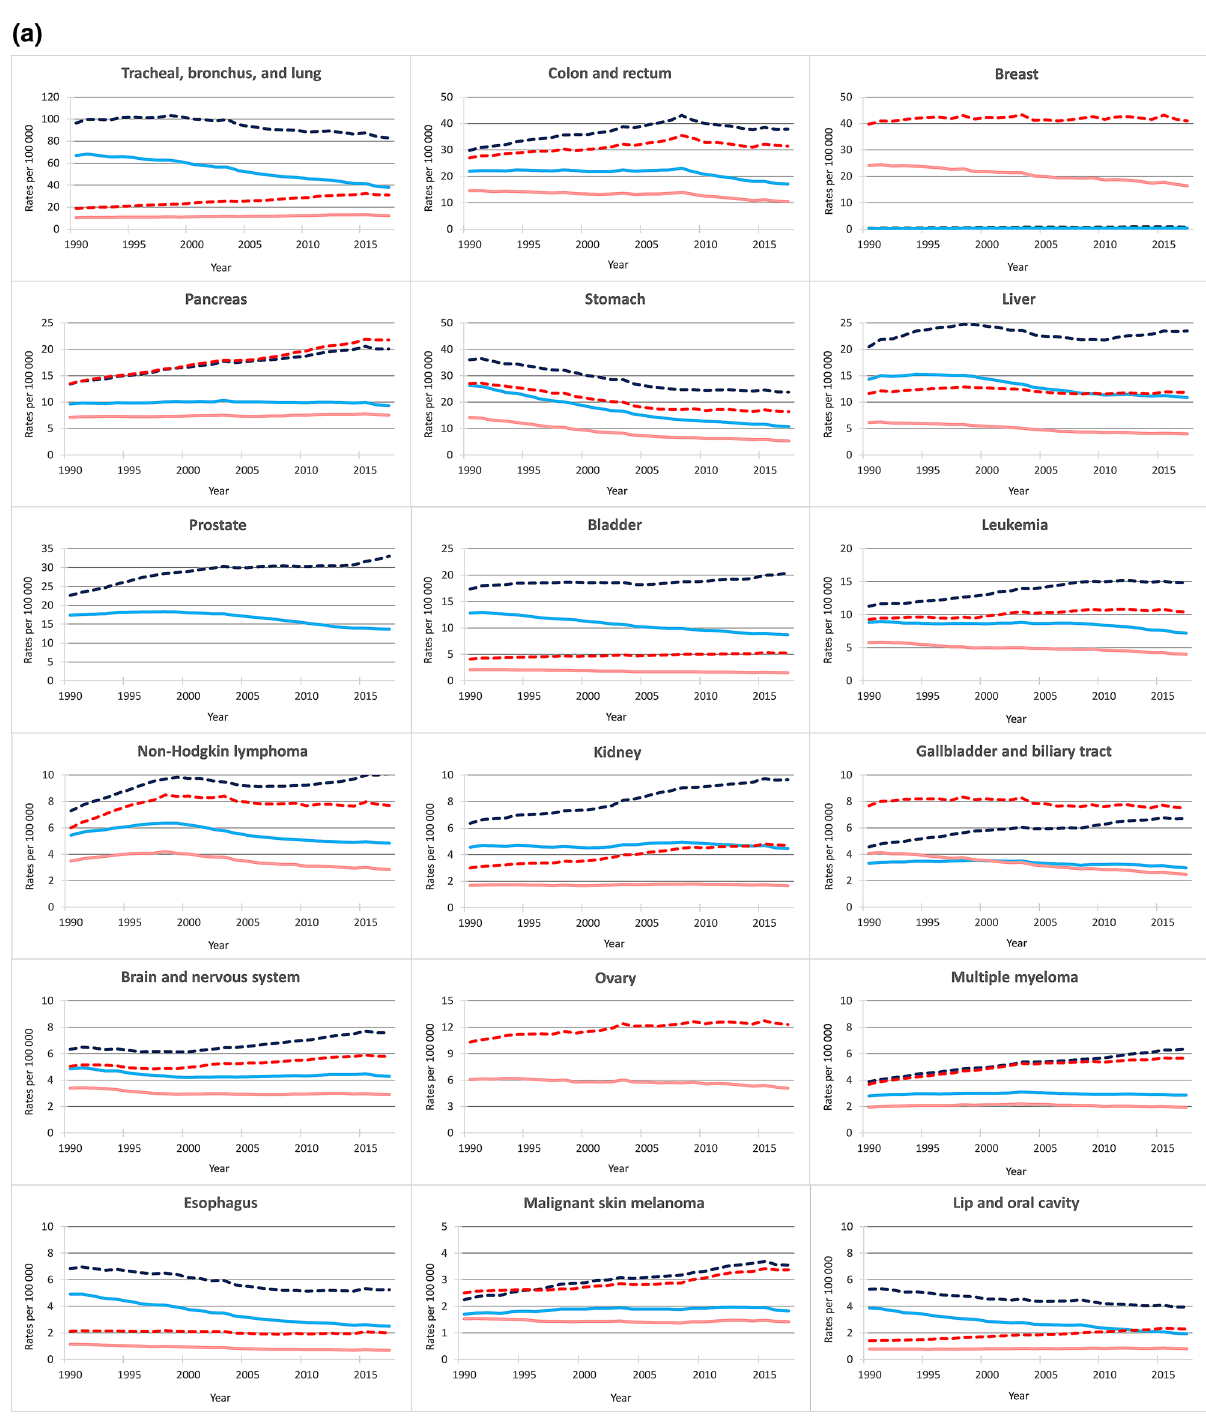
Figure 2. Trends in age-standardized and all ages death rates for 30 cancer groups (ordered by ranking in number of deaths in 2017), Italy, 1990–2017. ( a ) Cancer of the: trachea, bronchus, and lung; colon and rectum; breast; pancreas; stomach; liver; prostate; bladder; leukemia; non-Hodgkin lymphoma; kidney; gallbladder and biliary tract; brain and nervous system; ovary; multiple myeloma; esophagus; malignant skin melanoma; and lip and oral cavity. ( b ) Cancer of the: mesothelioma; cervix, uterus; larynx; non-melanoma skin; other pharynx; nasopharynx; thyroid; Hodgkin lymphoma; testis; other malignant neoplasms; and other neoplasms. Legend: Solid lines show age-standardized death rates for men (light blue) and women (light red), dashed lines show all ages death rates for men (blue) and women